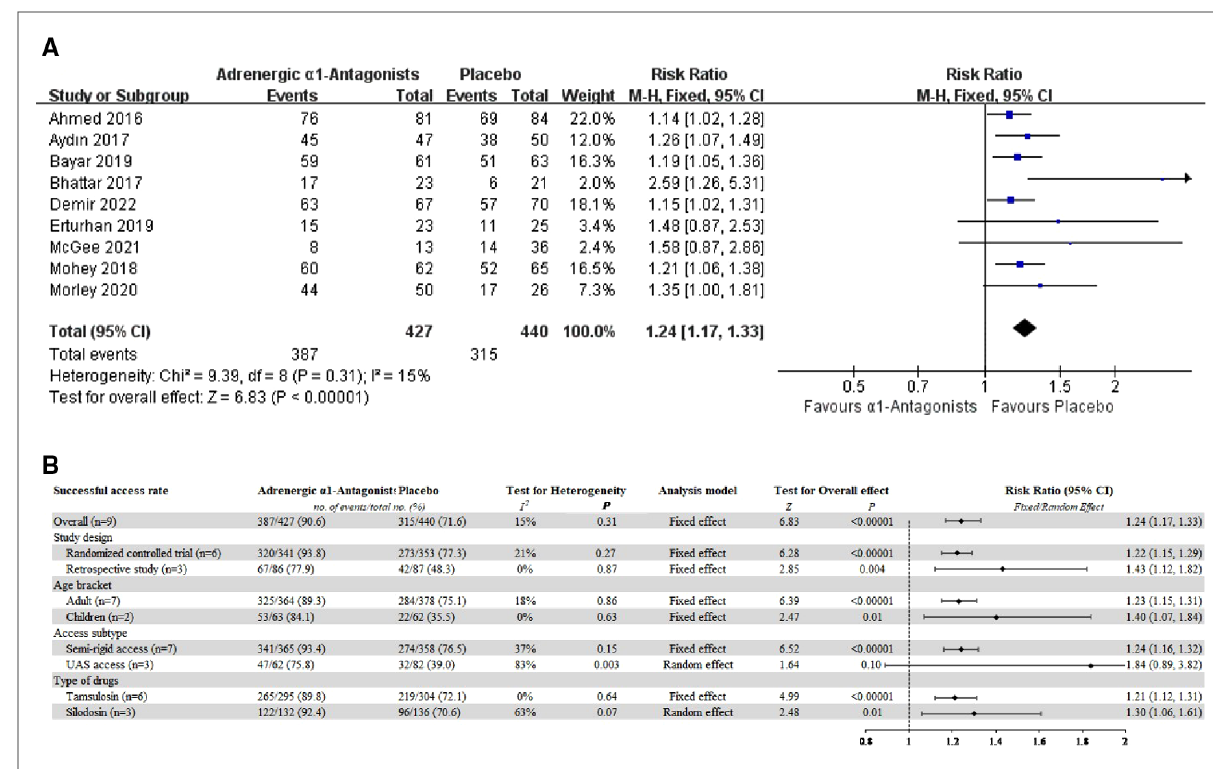
FIGURE 2 ( A ) Forest plot for overall successful access rate of RIRS. ( B ) Forest plot for subgroup analysis.